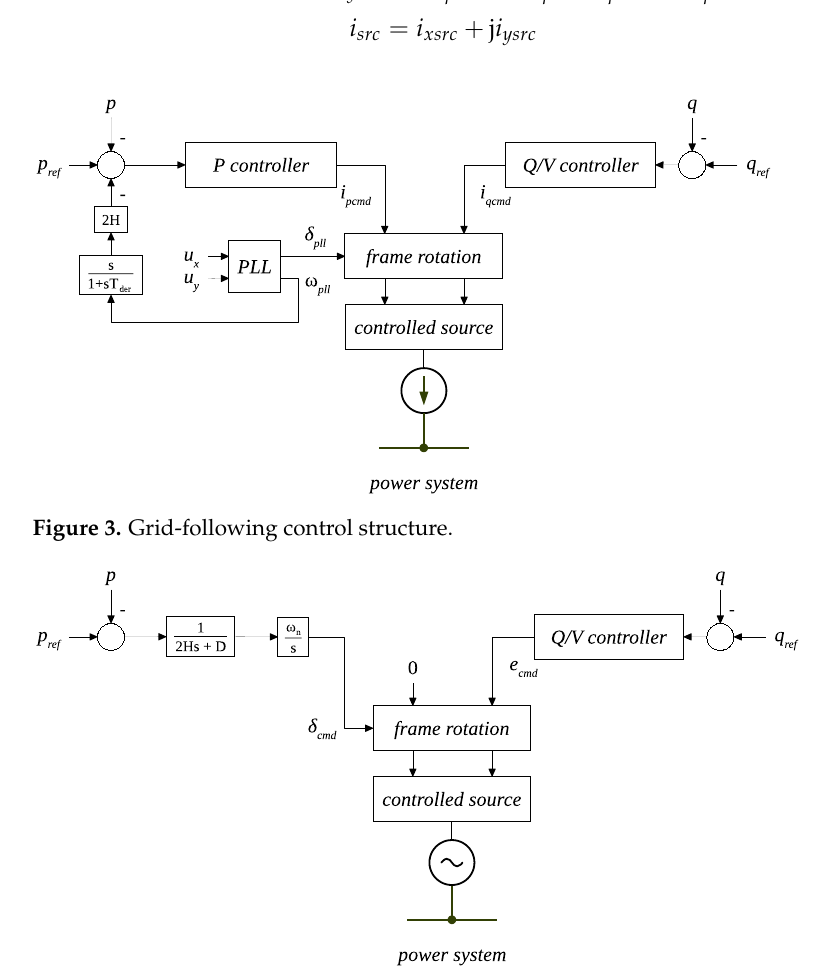
Figure 4. Grid-forming control structure. The synchronisation through PLL is implemented with (3), (4), (6), and (7), where u x and u y are inputs to the PLL, and they represent the real and imaginary parts of the terminal voltage in the coordinate frame of the system. The voltage u q is the imaginary part of the voltage in the local coordinate frame of the converter, and it is obtained by complex rotation of the terminal voltage using the angle δ pll , provided by the PLL. The active and reactive power controllers are described by (1), (2), (11), and (12), and they implement